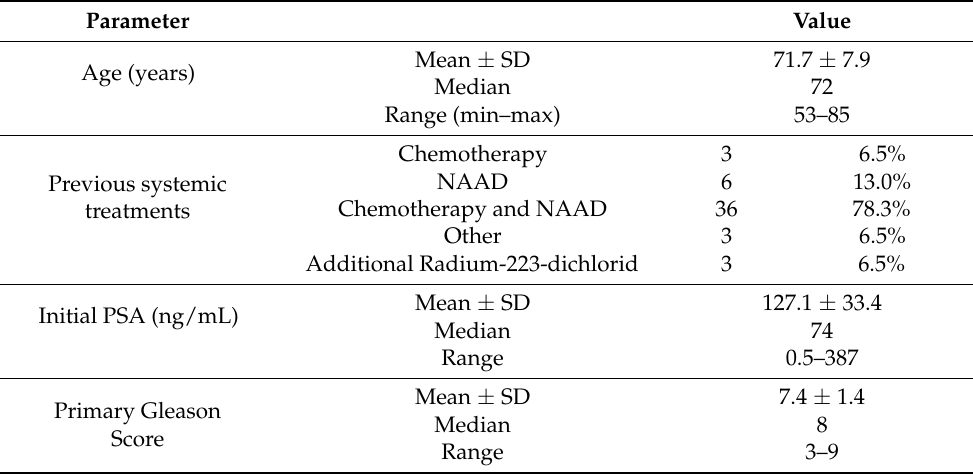
Table 1. Characteristics of the included patient